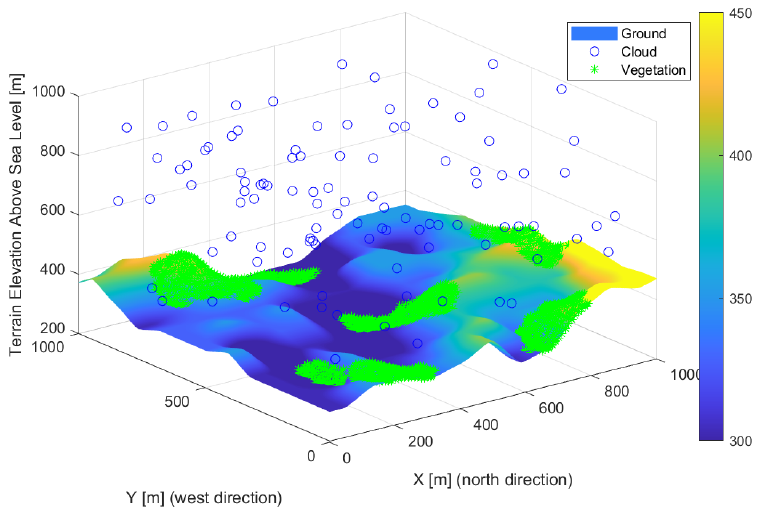
Figure 1. Model of the environment used for the studies, with elevation map, vegetation,